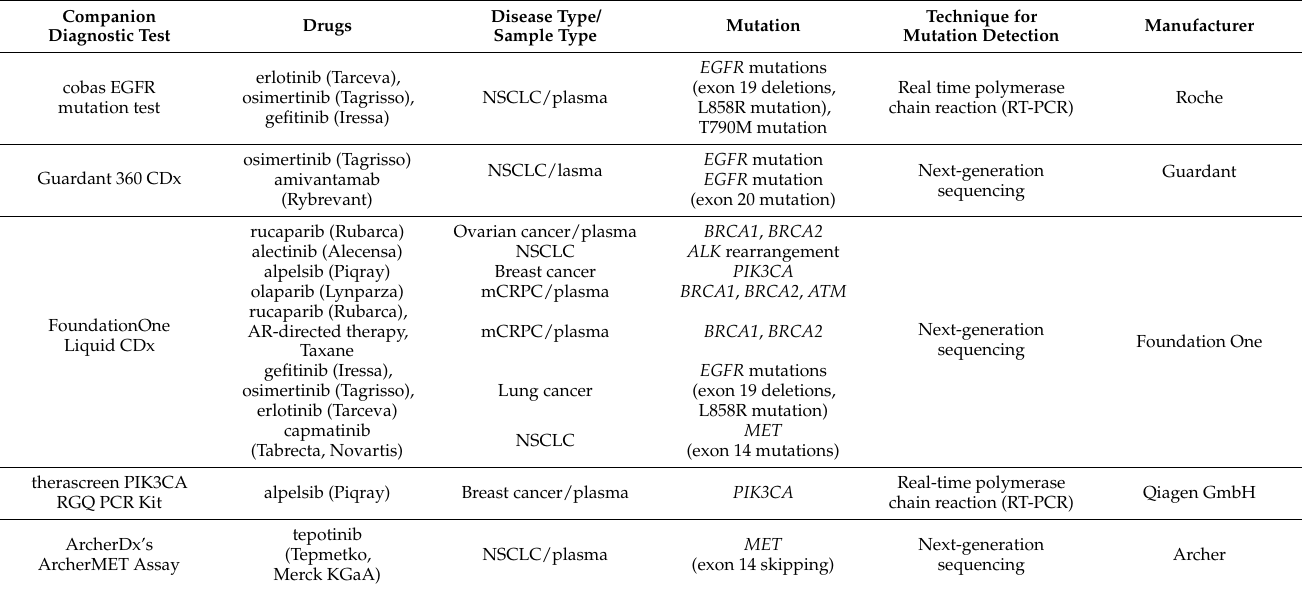
Table 3. FDA-approved liquid biopsy tests for companion